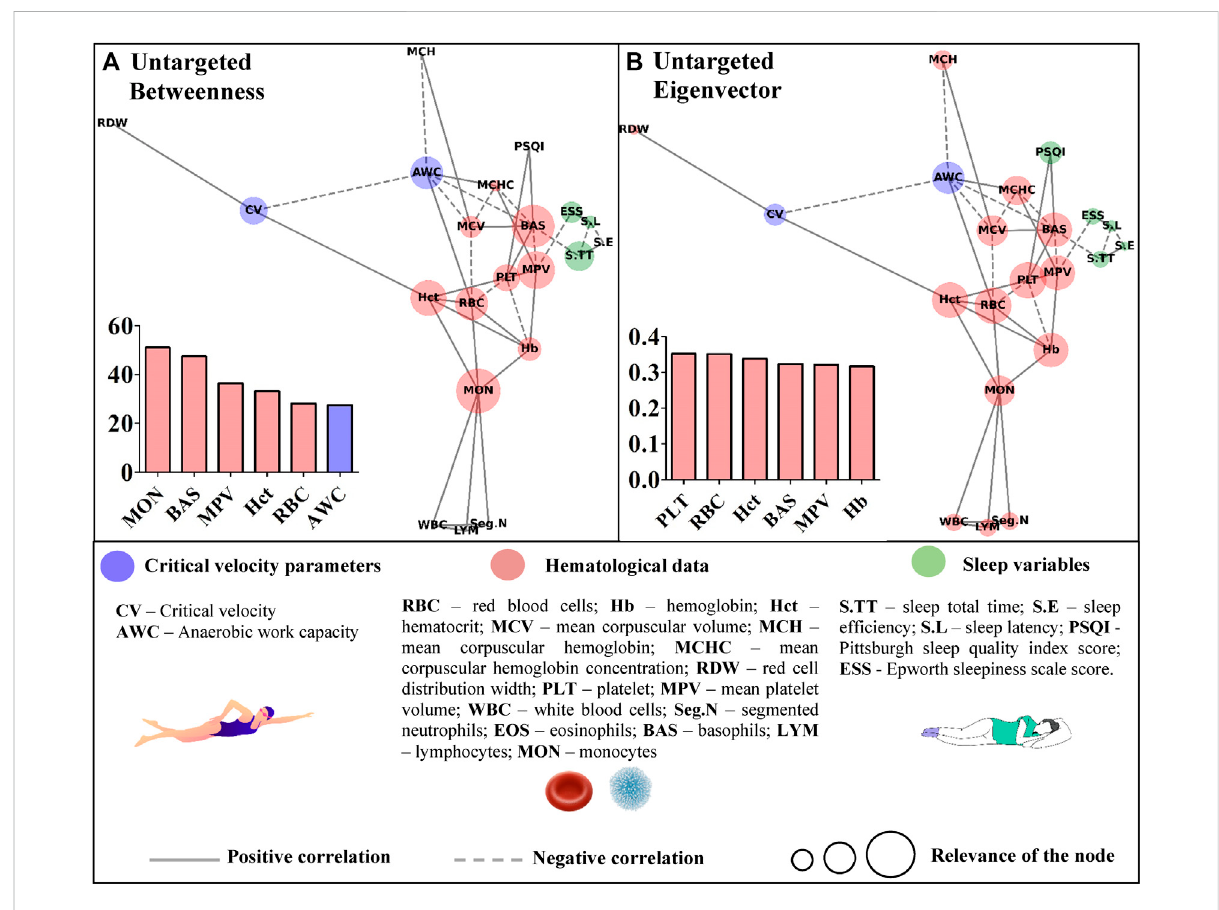
FIGURE 3 Centrality measurements from the untargeted complex network model; (A) betweenness analysis; (B) eigenvector